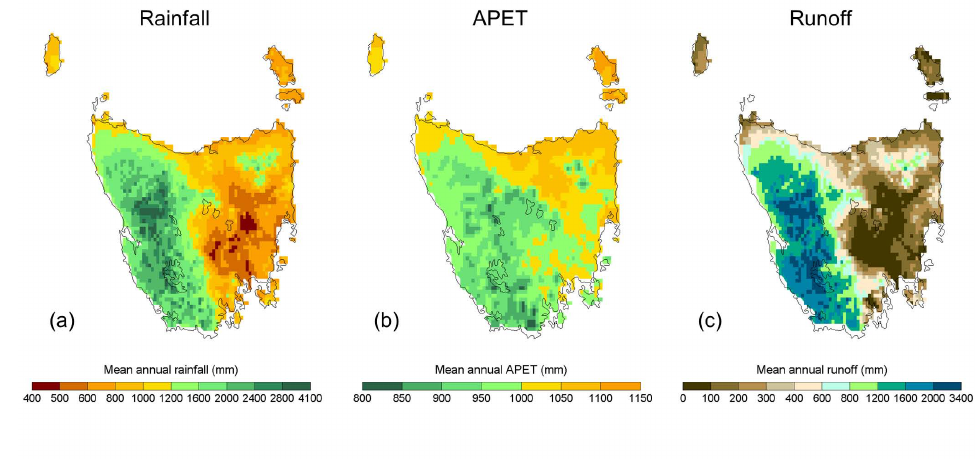
Fig. 2. Tasmanian historical climate (1961–2007) derived from the SILO climate dataset (Jeffrey et al., 2001). (a) Mean annual rainfall. (b) Mean annual Morton’s (1983) wet APET calculated from SILO temperature, solar radiation and vapour pressure. (c) Mean annual runoff generated with the SIMHYD model using SILO